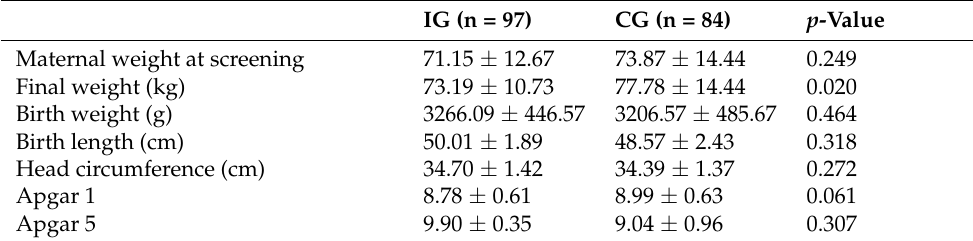
Table 6. Women without GDM.